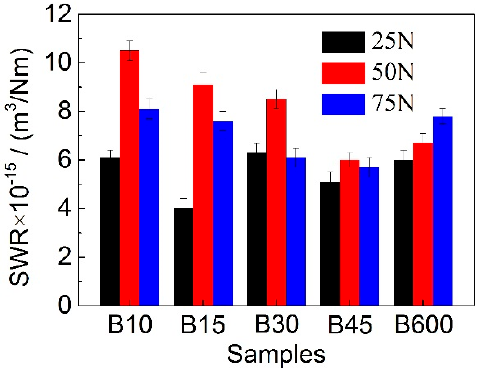
Figure 4. Variation of SWR of samples after wear testing under various loads.